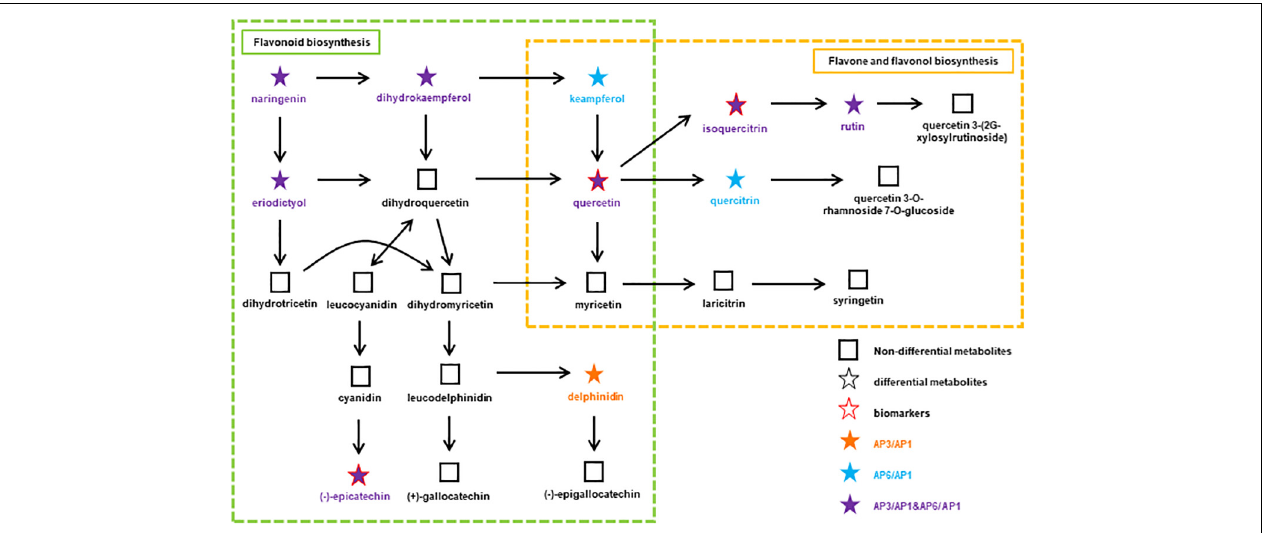
FIGURE 5 | At different growth stages, the flavonoids metabolic pathway in A. pedunculata leaves. The orange dot indicates that the substance is present in the AP3/AP1 samples; the blue dots indicate that the substances are present in the AP6/AP1 samples; the purple dots indicate that the substances are present in both